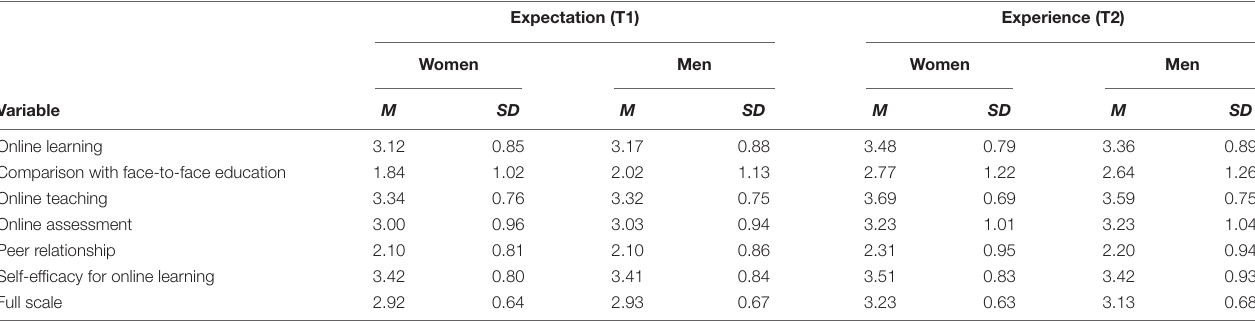
TABLE 4 | Descriptive data on the expectations and experience of university students considering gender. Expectation (T1) Experience